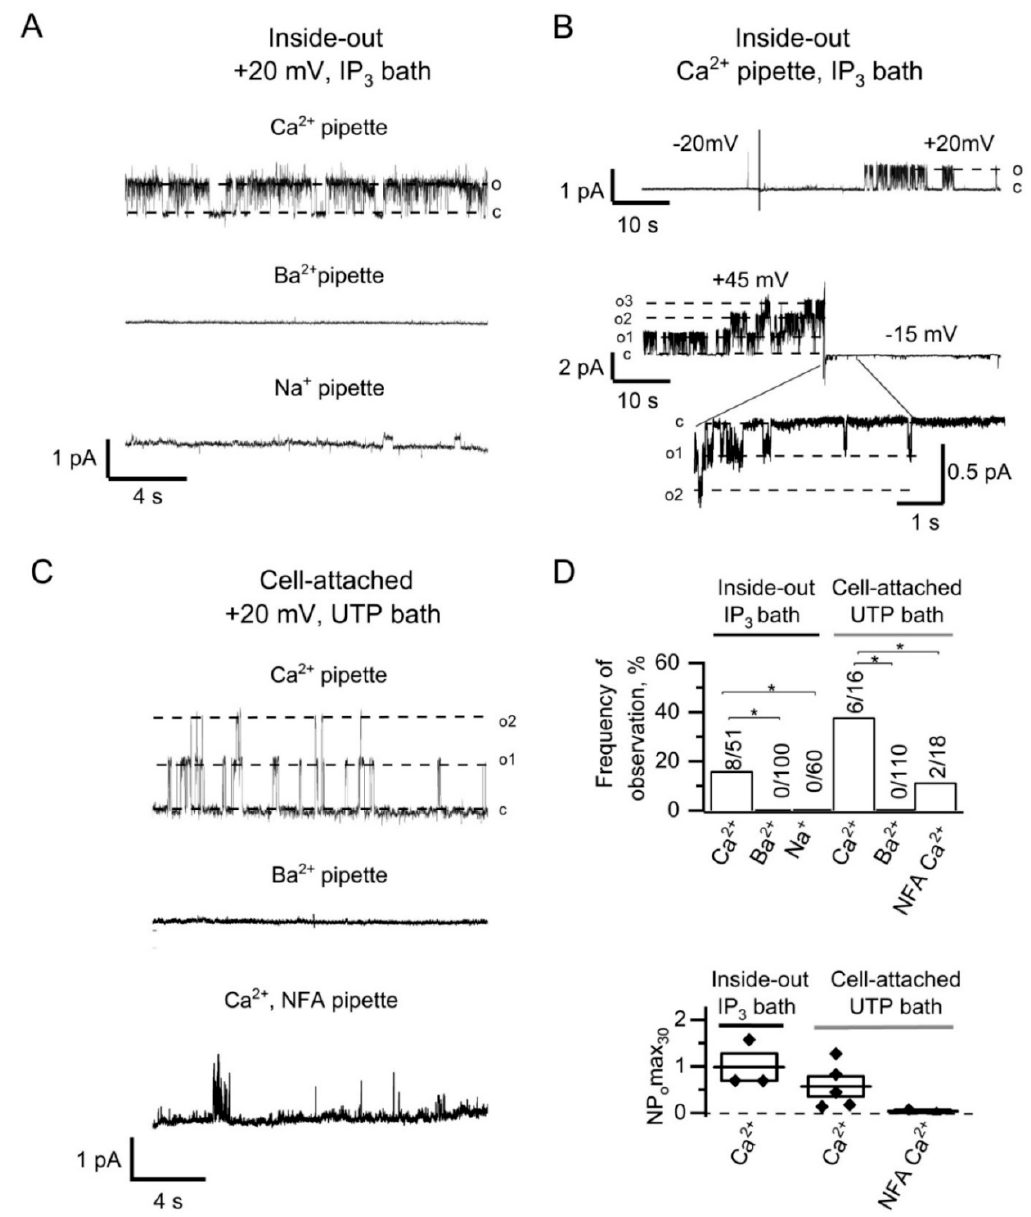
Figure 2. Induction of CaCCs activity by IP 3 -mediated Ca 2+ entry in HEK293 cells. ( A ) Current recordings after bath application of 2.5 µ M IP 3 to inside-out patches with 105 Ca 2+ in pipette solution (top), 105 Ba 2+ in pipette solution (middle), and 140 Na + in pipette solution (bottom). Patches were held at +20 mV membrane potential. ( B ) IP 3 -induced CaCC currents in inside-out patches after switching to positive (top) or to negative (bottom) potential. ( C ) Current recordings after bath application of 100 µ M UTP to cell-attached patches with 105 Ca 2+ in pipette solution (top), 105 Ba 2+ in pipette solution (middle), and 105 Ca 2+ in the presence of 100 µ M NFA in pipette solution (bottom). ( D ) The summary plot of the frequency of CaCCs observation (top) and the CaCC open channel probability (bottom) for series from the panels A–C. The frequency of CaCCs observation reflects a proportion of positive experiments to the total number of experiments. Differences are considered significant when p values are <0.05 (*), and <0.01 (**).